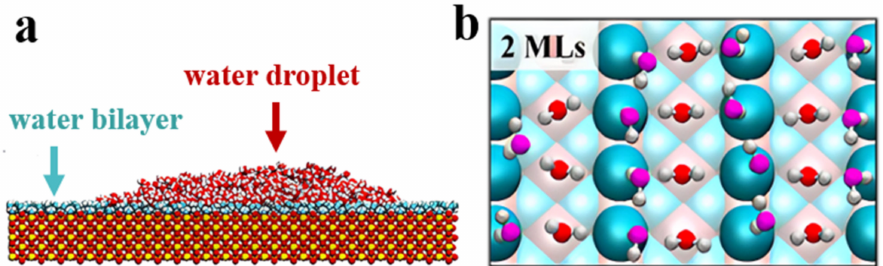
Figure 2. ( a ) Side-view snapshot of the rutile TiO 2 (110) solid with a water droplet (red and white balls) coexisting with the water bilayer (cyan and white balls). ( b ) Snapshots of the ordered water structures for 2 MLs of H 2 O adsorbed on rutile TiO 2 (110). The atoms are color coded as follows: Ti (pink), O of TiO 2 (cyan), O of H 2 O (first layer: red; second layer: magenta), and H (white). (Reprinted from Ref. [88], Copyright 2022 Royal Society of